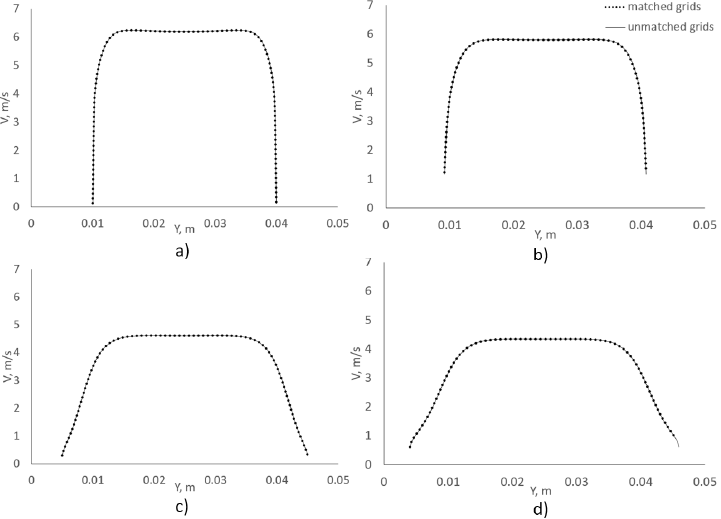
Figure 18. Profile of velocity at the control sections: ( a ) section A1, ( b ) section A2, ( c ) section A3, ( d ) section A4.